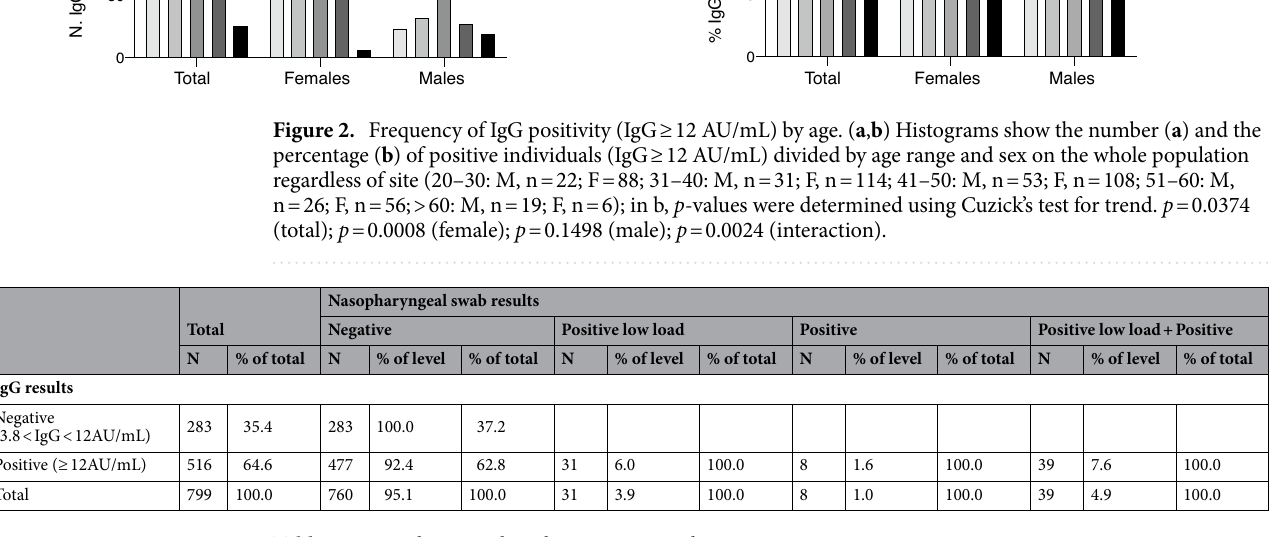
Table 3. Nasopharyngeal swab positivity in relation to IgG